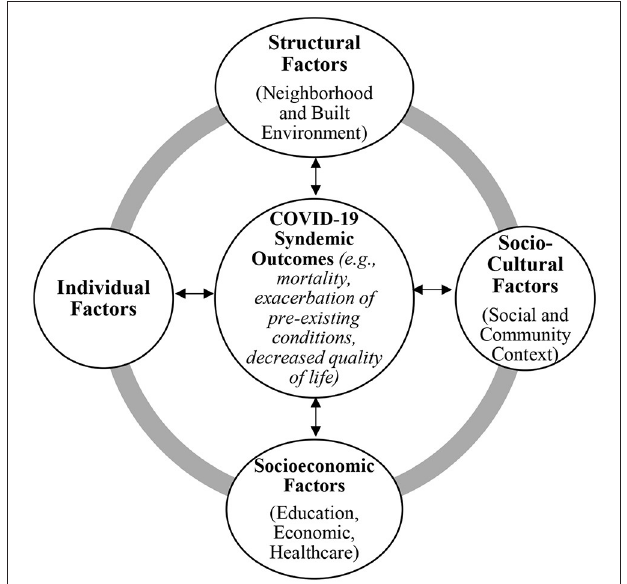
FIGURE 1 | Interactions among the SDoH and the Bi-directional Relationship with the COVID-19 Syndemic. Social determinants of health (SDoH) that can interact to influence health outcomes for all populations with specific emphasis on the COVID-19 syndemic are illustrated in this figure. Concurrently, the COVID-19 syndemic will influence these health factors, as shown by the double-sided arrows. The gray outer circle illustrates the connection among the SDoH shown. The main categories illustrated are adapted from Mendenhall ( 26) and the model is adapted from HealthyPeople.gov Social Determinants of Health ( 25). Representative examples for each category are listed here: Structural Factors (e.g., poverty, food insecurity, poor quality housing, violence); Sociocultural Factors (e.g., acculturation, identity, lifestyle, family conflict and support, institutional support); Socioeconomic Factors (e.g., language and literacy, employment, access to primary care); and Individual Factors (e.g., genetics, health behavior,